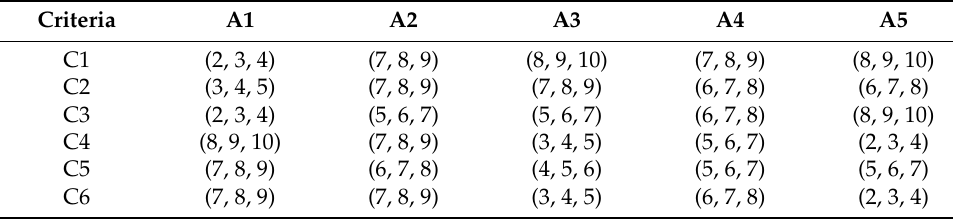
Table 6. Individual fuzzy performance rating matrix of expert 1.